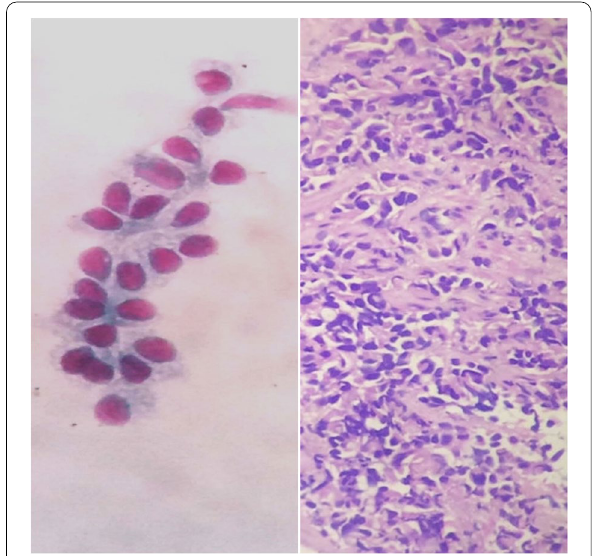
Fig. 2 Lung adenocarcinoma (PAP stained-squash smear cytology and H&E-stained histology slide); 100 ×